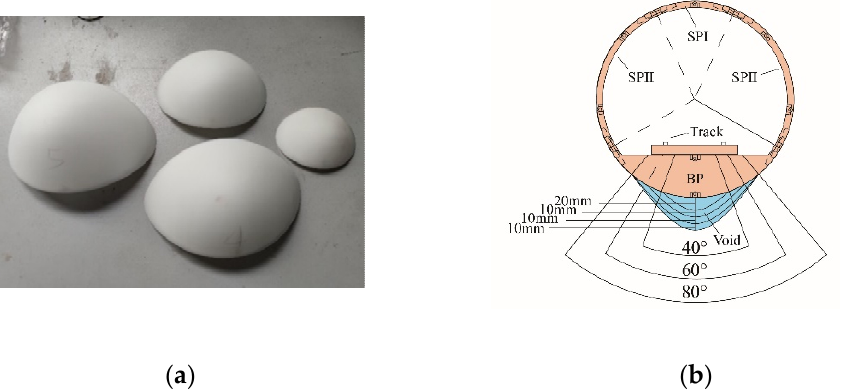
Figure 5. The shape and placement of the voids: ( a ) 3D-printed void, ( b ) void size and position.